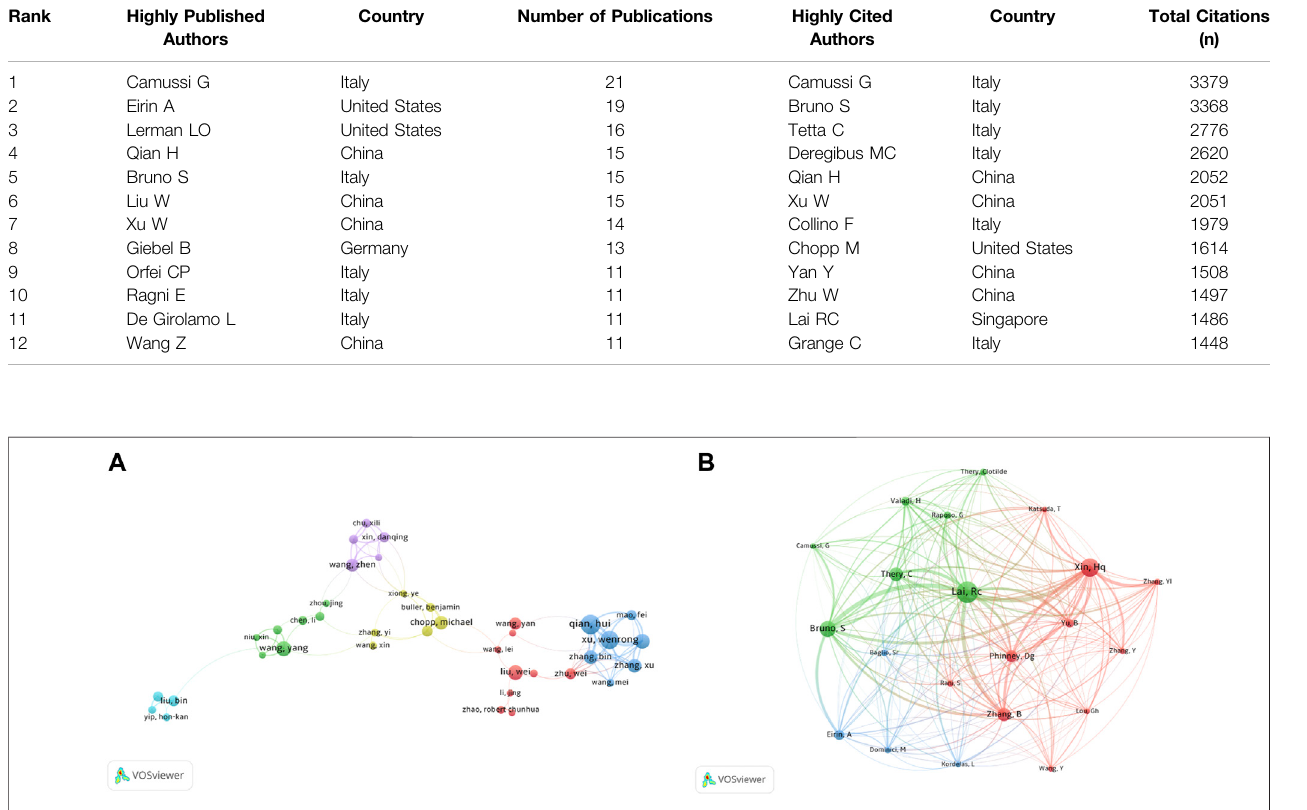
Frontiers in Bioengineering and Biotechnology |